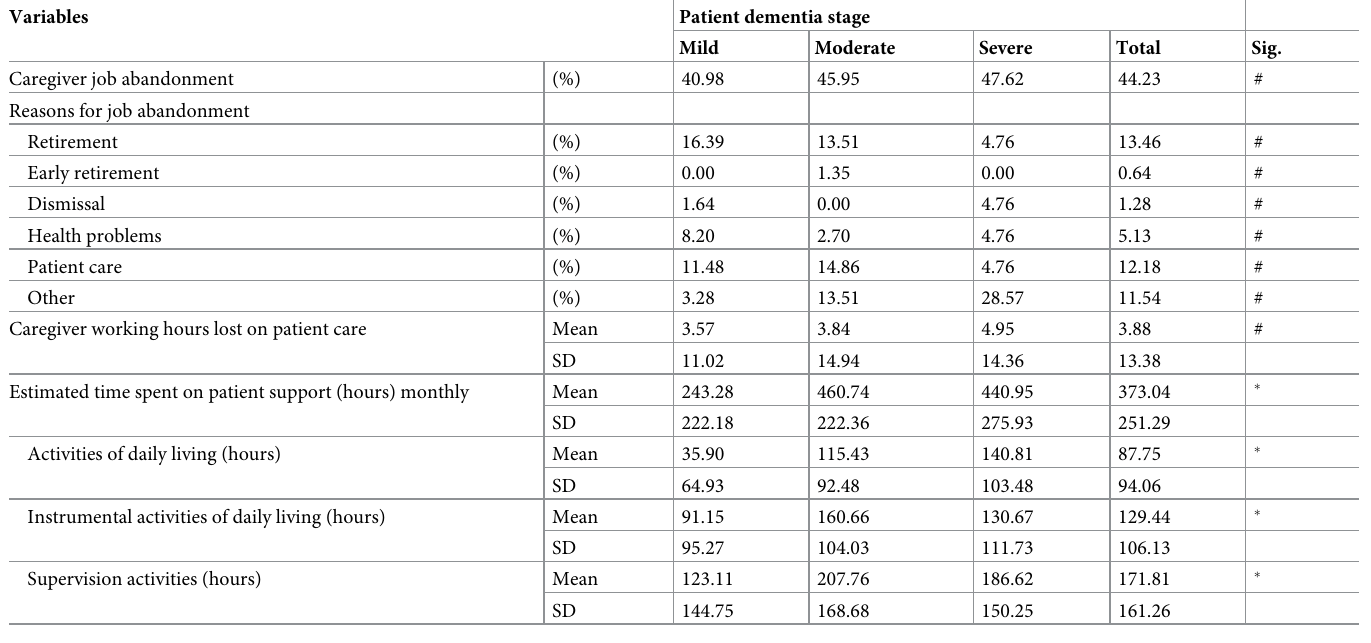
Table 4. Characteristics of productivity losses and economic impact for caregivers, according to patient FAST category. Brazil,